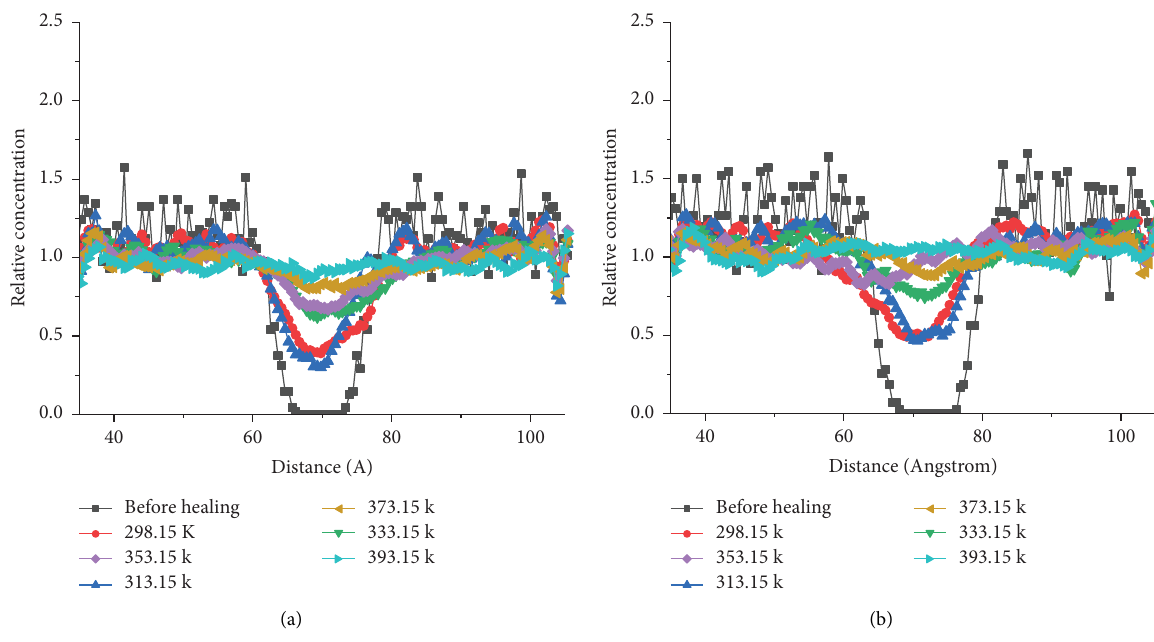
Figure 14: Relative concentration distributions of Fe 2 O 3 -asphalt (a) and SiO 2 -asphalt (b) in the OZ